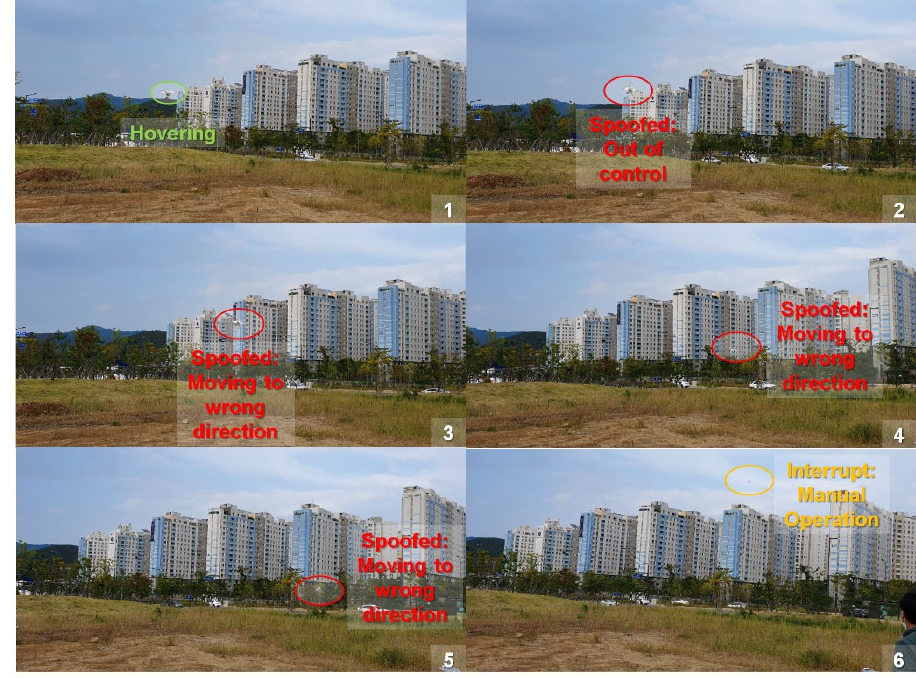
Figure 12. Spoofed DJI Phantom in the flight test.